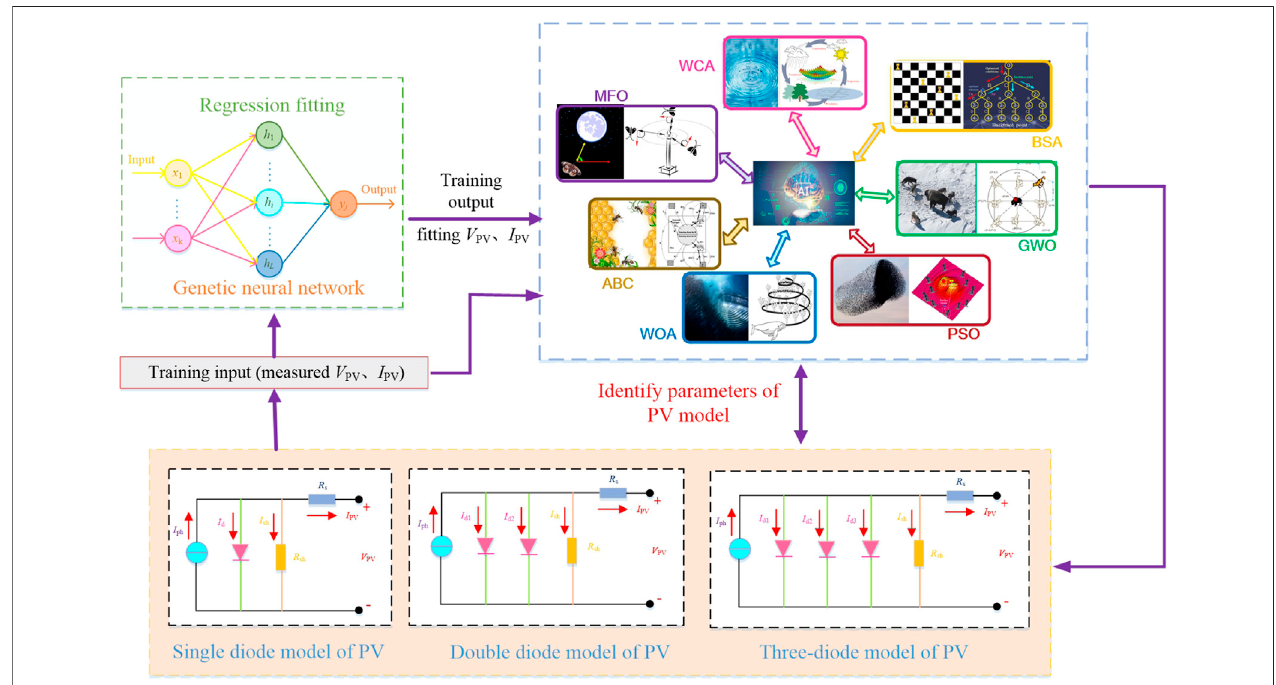
FIGURE 4 | Framework of GNN-based data-driven optimization procedure for PV cell parameter estimation.